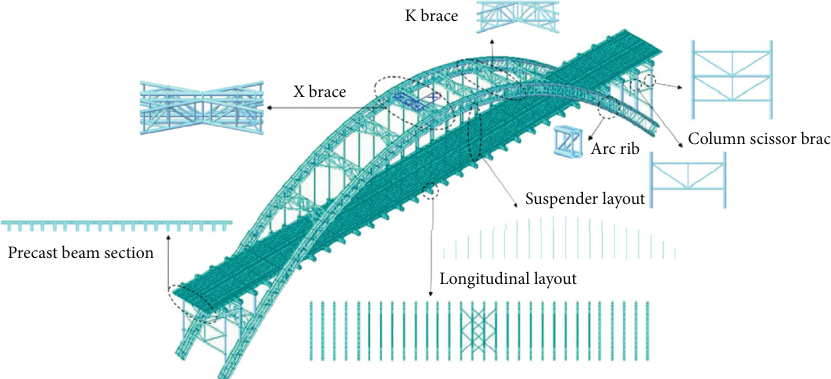
Figure 6: Finite element model of the bridge.